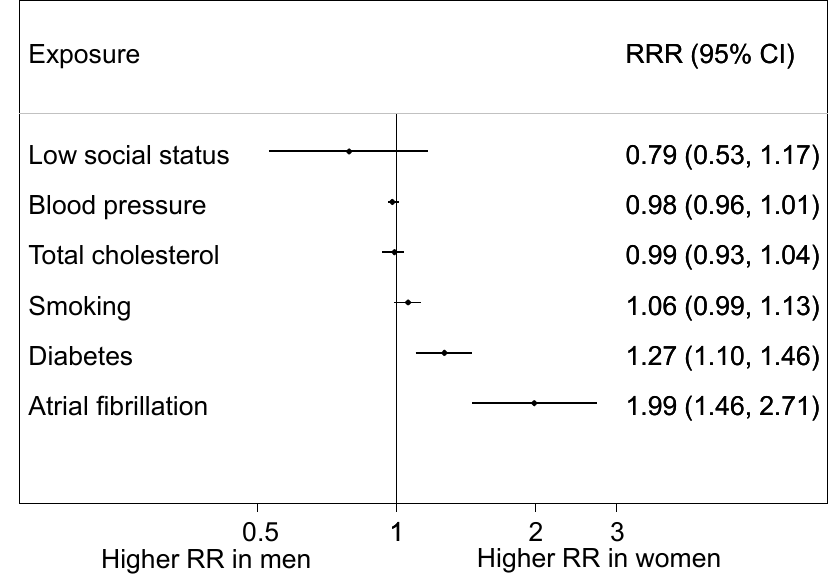
Figure 7. Women-to-men RRRs for stroke: pooled results from meta-analyses. Conventions as in Figure 6.